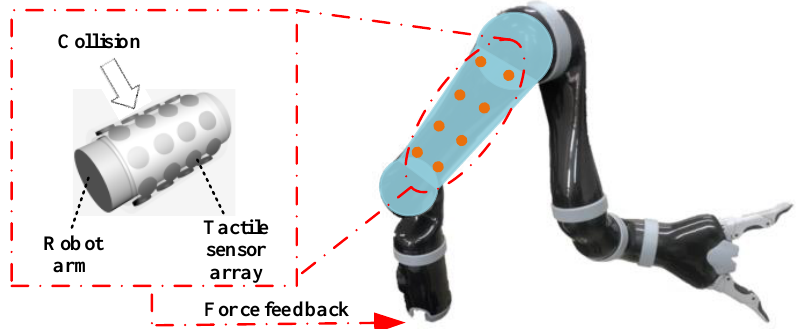
Figure 1. The strategy to obtain an energy-efficient